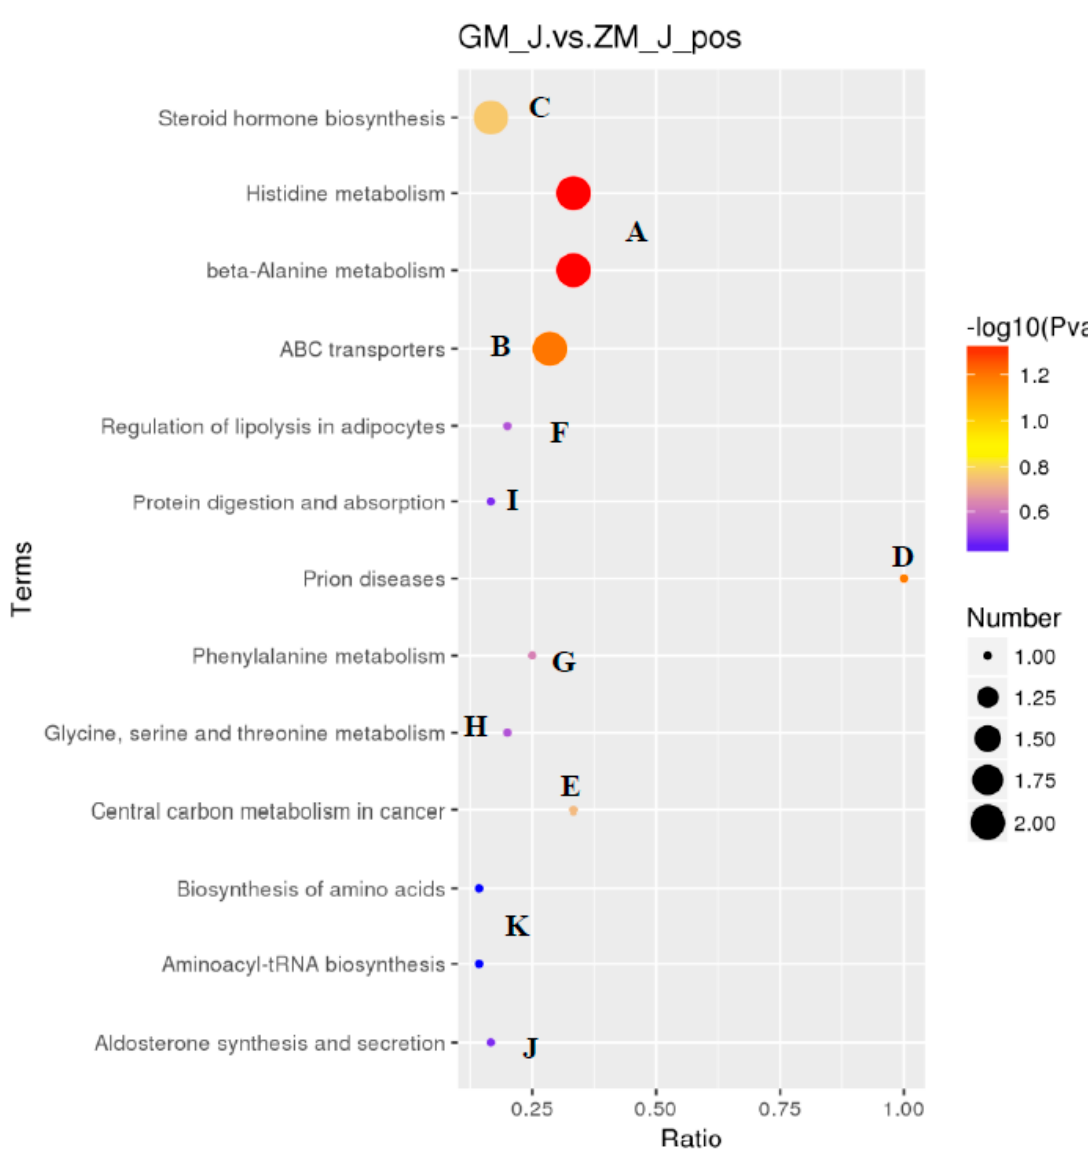
Figure 2. Disturbed pathways in response to a high-fat diet. A. Histidine metabolism and beta-Alanine metabolism; B. ABC transporters; C. Steroid hormone biosynthesis; D. Prion diseases; E. Central carbon metabolism in cancer; F. Regulation of lipolysis in adipocytes; G. Phenylalanine metabolism; H. Glycine, serine and threonine metabolism; I. Protein digestion and absorption; J. Aldosterone synthesis and secretion; K. Aminoacyl-tRNA biosynthesis and biosynthesis of amino